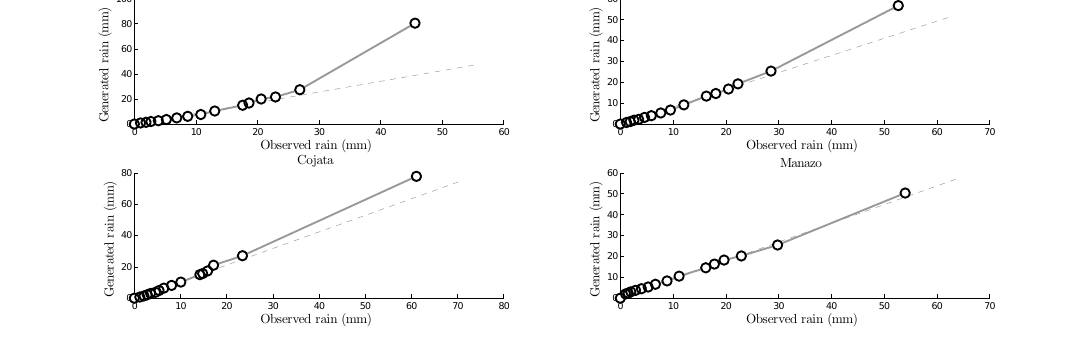
Figure 14. Quantile–quantile